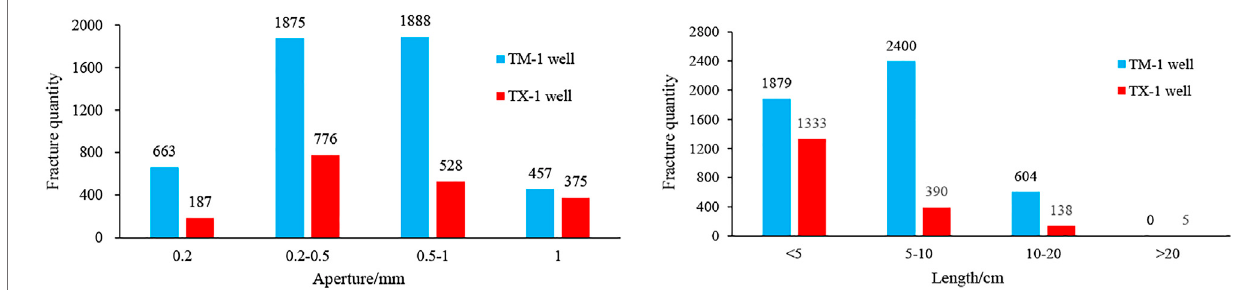
FIGURE 9 | Fracture aperture and length histogram of Niutitang shale in Cen ’ gong block.